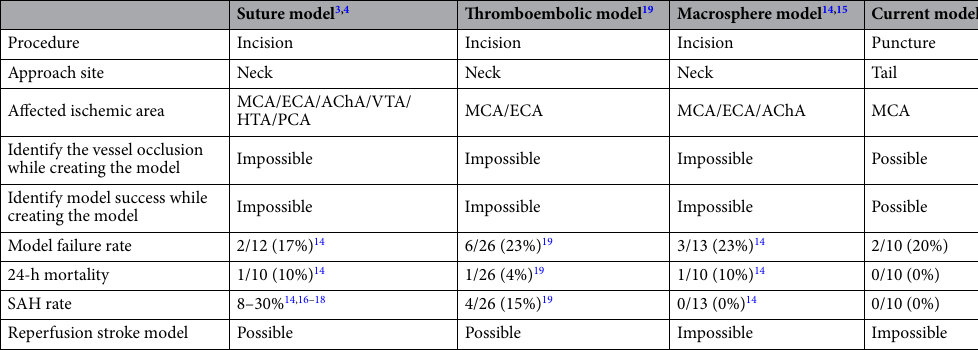
Table 1. Comparison between the most prevalent rodent stroke models and the model in the current study. AChA anterior choroidal artery, ECA external carotid artery, HTA hypothalamic artery, MCA middle cerebral artery, PCA posterior cerebral artery, SAH subarachnoid hemorrhage, VTA ventral thalamic